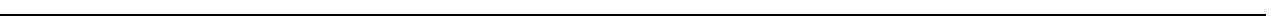
Fig. 5 G9a-mediated transcriptional repression of HEPH is HMTase-dependent. Relative HEPH mRNA a and protein levels b of HEPH in G9a knockdown, G9a WT, and G9a SET domain deleted rescued MDA-MB-231 cells. c Schematic diagram of primer pairs of the human HEPH promoter region